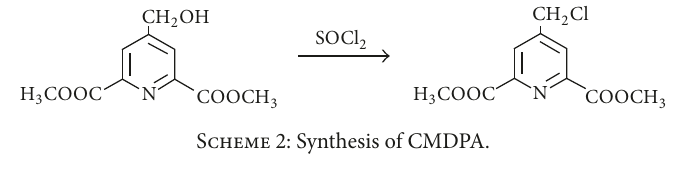
Scheme 2: Synthesis of CMDPA.